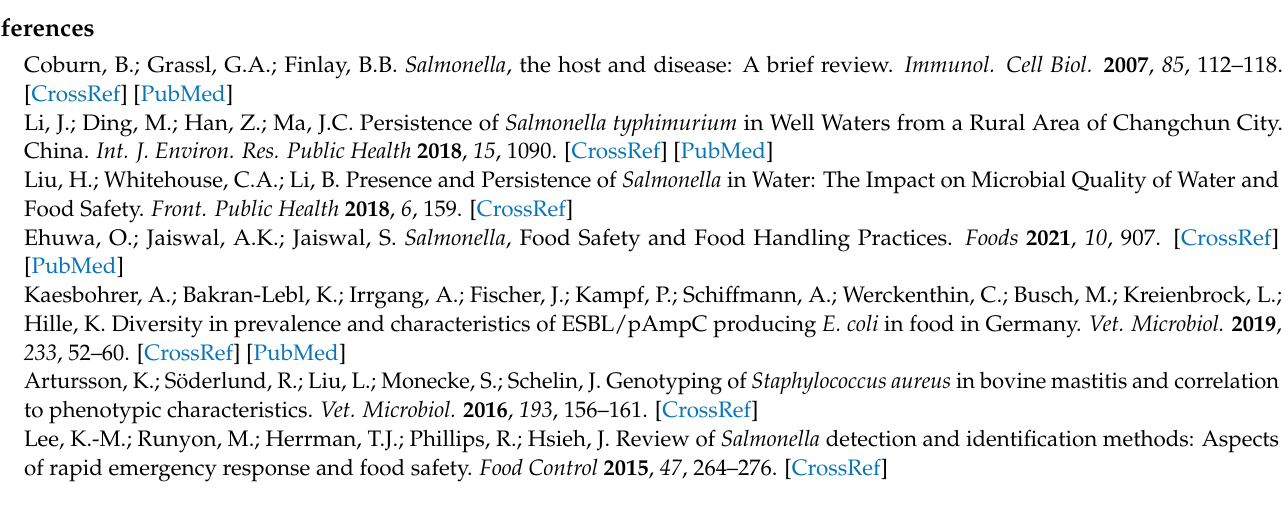
scale bars; Figure S2: Surface area calculation for IONPs and ICGNPs; Table S1: The diameter of